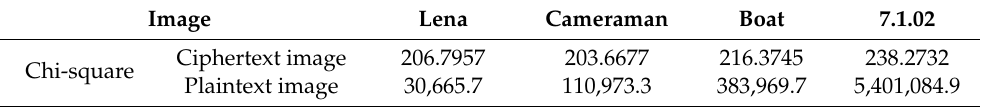
Table 4. Chi-square.